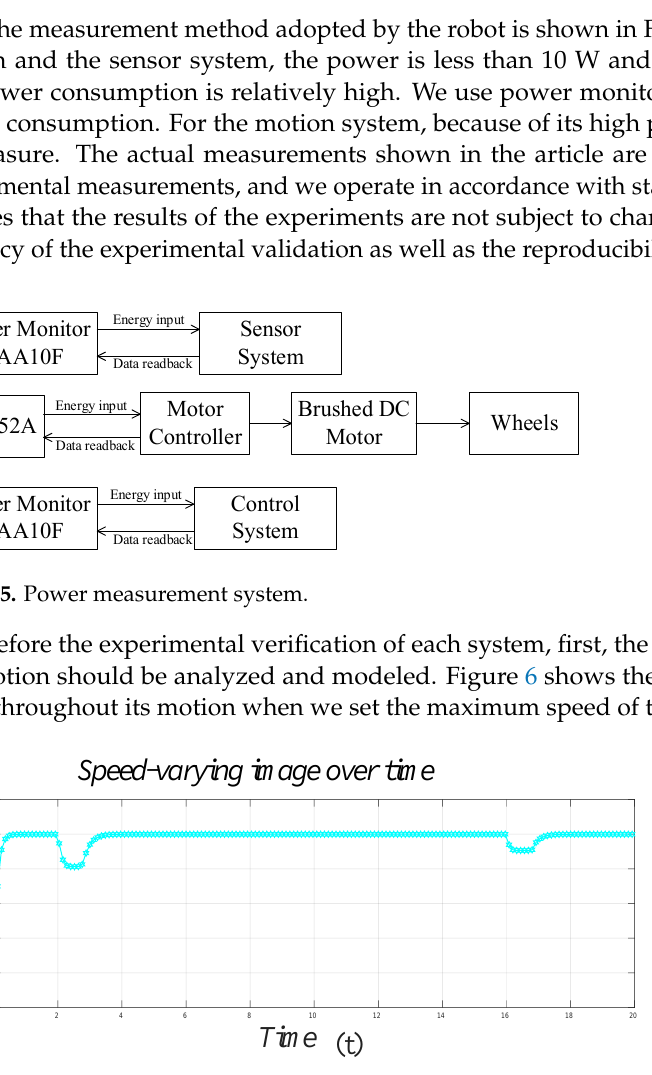
Figure 4. Robot experiment process diagram.